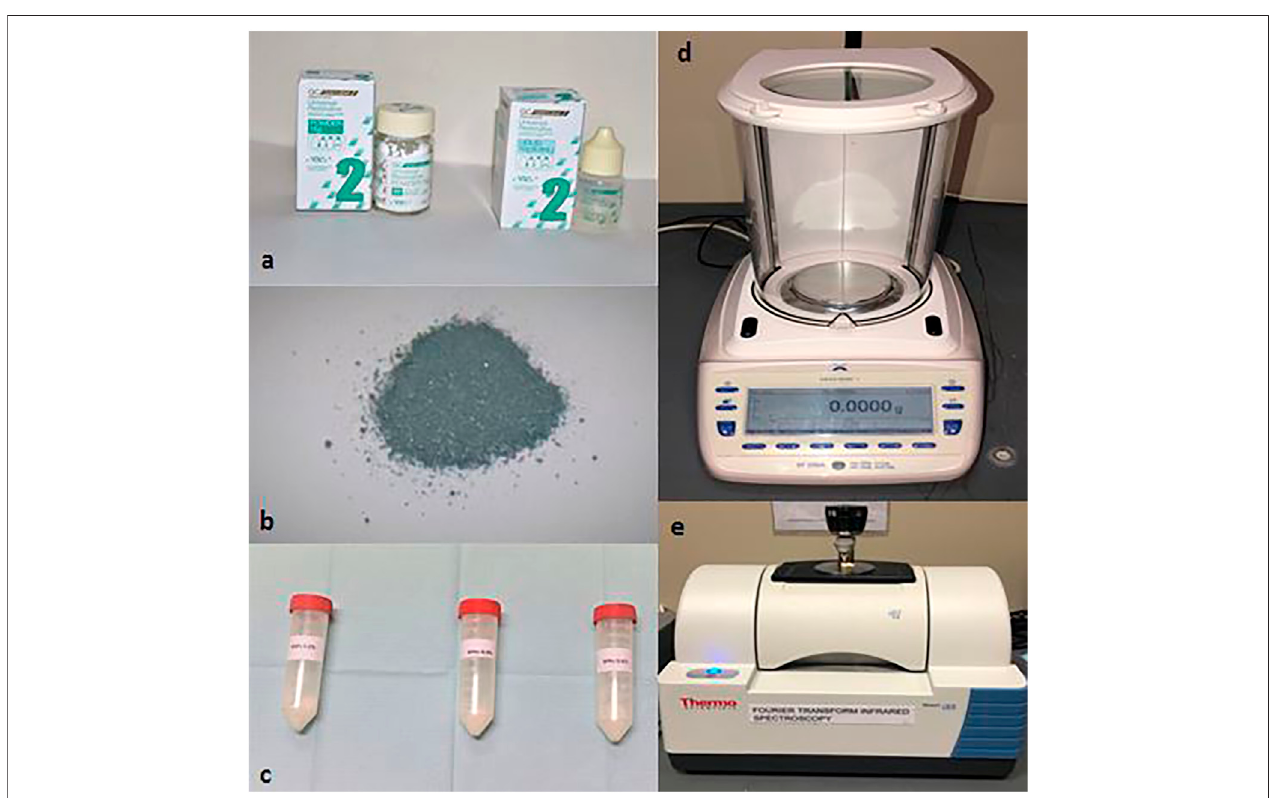
FIGURE1|(A) GCFujiIIpowderandliquid; (B) silvernanoparticle(AgNP)powderused formaking samples; (C) mixedGIC powderandsilvernanoparticle(AgNP) powder with different concentrations 0.2, 0.4, and 0.6%; (D) electronic weighing scale used for measuring the weight of the GIC powder and other substance(s); (E) Fourier-transform infrared spectroscopy